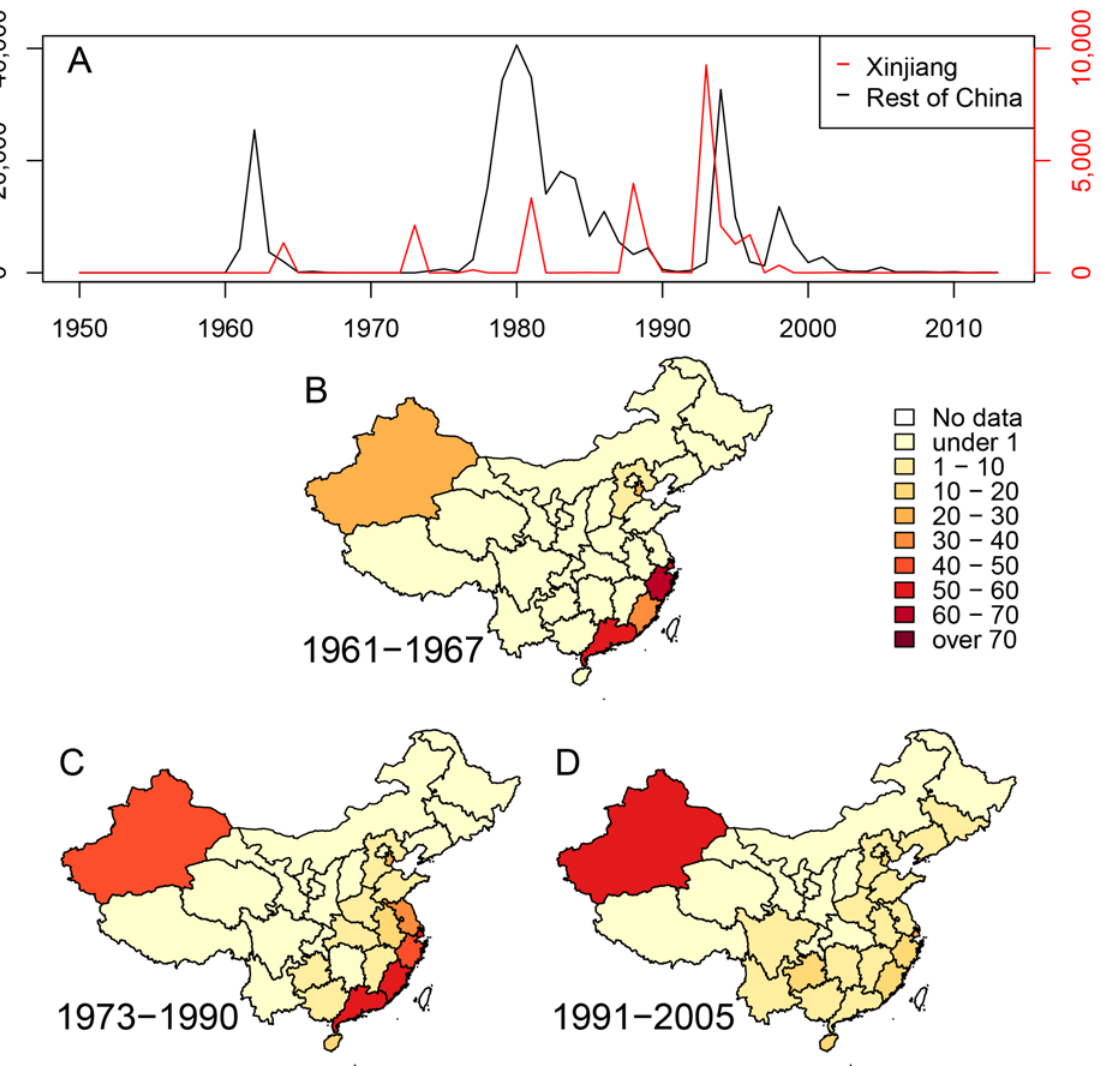
Fig 1. Cholera in China since 1950. (A) Numbers of cases of cholera per year in the Xinjiang region (red, scale at right) and the rest of China (black, scale at left). (B-D) Density of cases of cholera in China during three epidemiological waves of disease: 1961 – 1967, 1973 – 1990 and 1991 – 2005. Each province is colored by numbers of cases per million inhabitants per